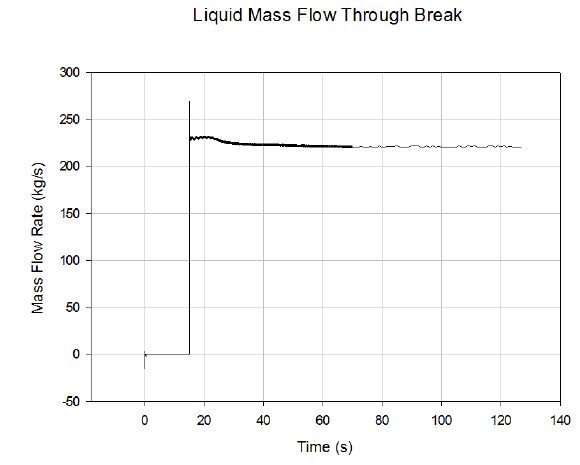
Figure 19. Fuel temperature at ejection point.